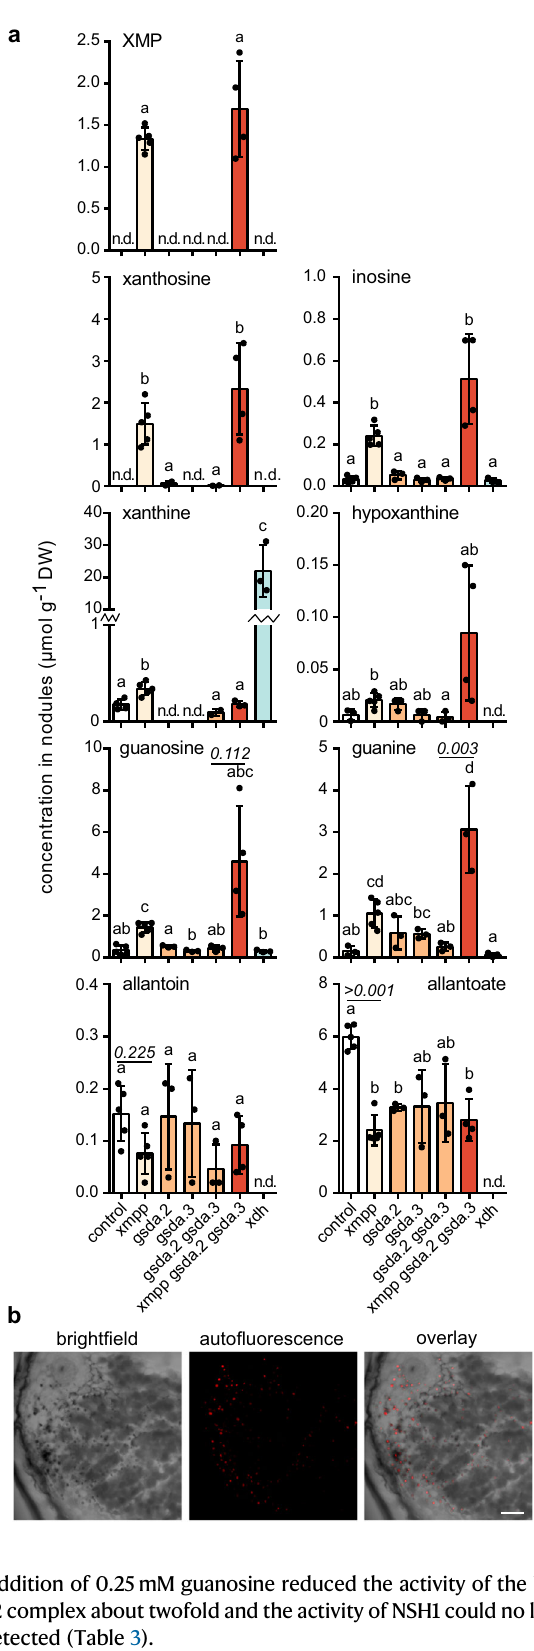
Fig. 2 | Metabolic alterations in nodules of XMPP , GSDA and XDH genetic var- iants and fl uorescent bodies in xdh nodules. a Quanti fi cation of metabolites of purine catabolism and ureide synthesis in nodule extracts. Error bars are SD, measure ofthe center is the meanvalue, n=5 forcontroland xmpp , n=4 for xmpp gsda.2gsda.3 , n= 3for gsda.2,gsda.3,gsda.2gsda.3 and xdh .Arepeat( n )isapoolof nodules from a single transgenic root. Although different mutant roots / nodules can come from the same plant, in this experiment all null-mutant nodules came from roots of independent plants grown together. Statistical analysis with two- sided Tukey ’ s pairwise comparison using the sandwich variance estimator. Differ- ent letters indicate p values < 0.05. Selected p values are indicated,all p values can be found in the Source Data fi le. DW dry weight. b From left to right, bright fi eld image of an xdh nodule cross section with bacteroid infected (dark grey) and uninfected (light grey) cells and precipitates (black dots); confocal fl uorescence image of the same cross section with auto fl uorescent objects (excitation 552nm, emission 595 – 622nm); overlay of both images. Scale bar, 100 µ m. Image is repre- sentative of at least three nodules from independent transgenic roots. The experimentwasperformedonceinPhaseolusandonceinSoybean(Supplementary Fig. 4b, d, e) with similar